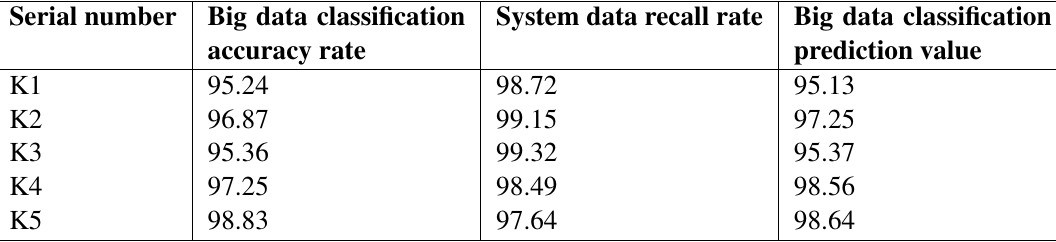
Table 3 Big data classification processing results of the system in this